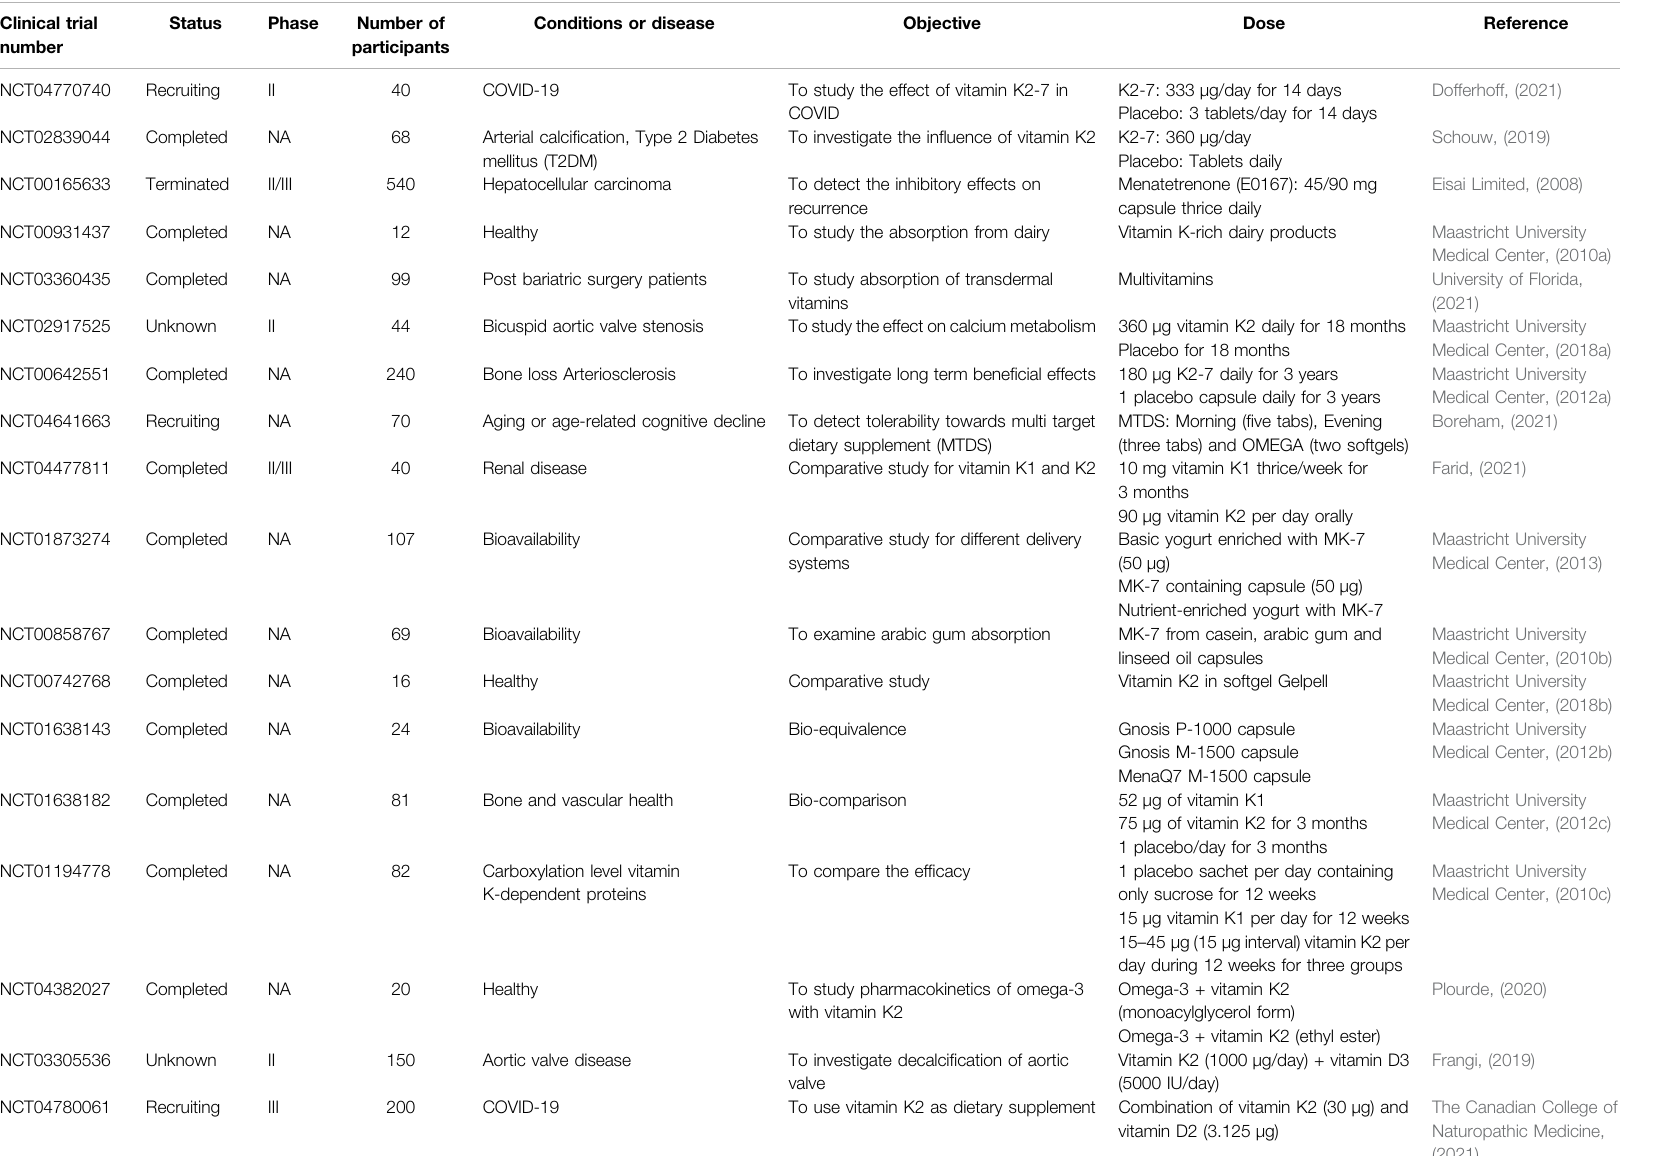
TABLE 3 | Clinical trials on vitamin K2-7 in the United States of America (Adapted from www.clinicaltrials.gov). Clinical trial